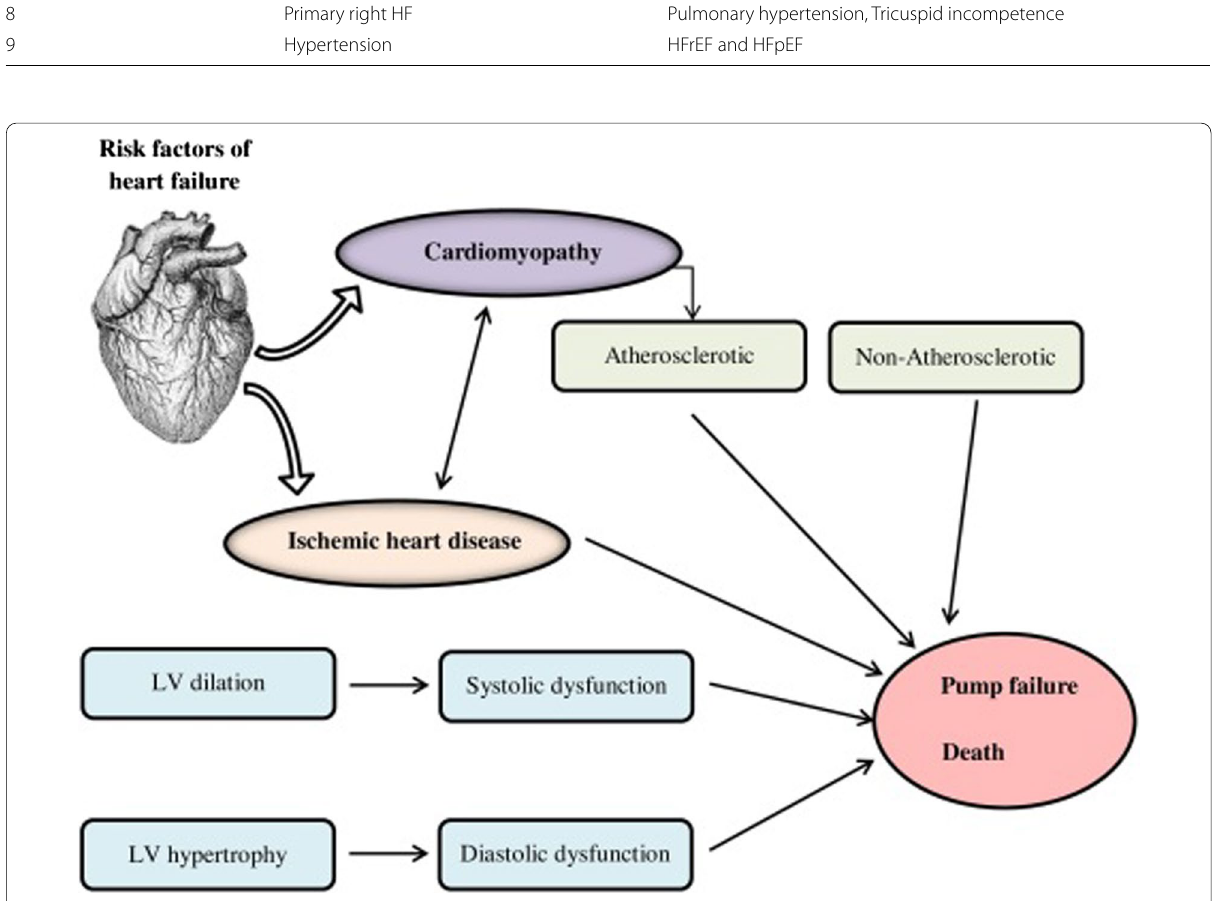
Fig. 3 Genetic risk factors of heart